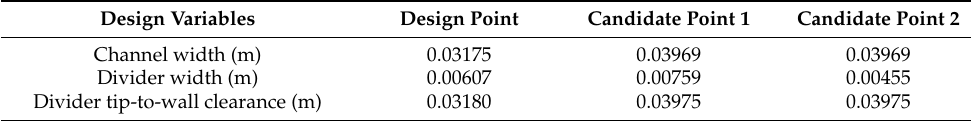
Table 3. Result of the response surface for two different Reynolds numbers.